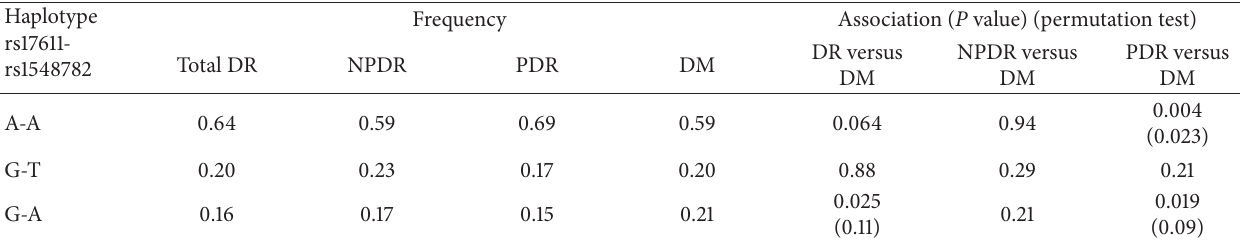
Table 5: Haplotype association of C5 gene with DR and its subtypes.